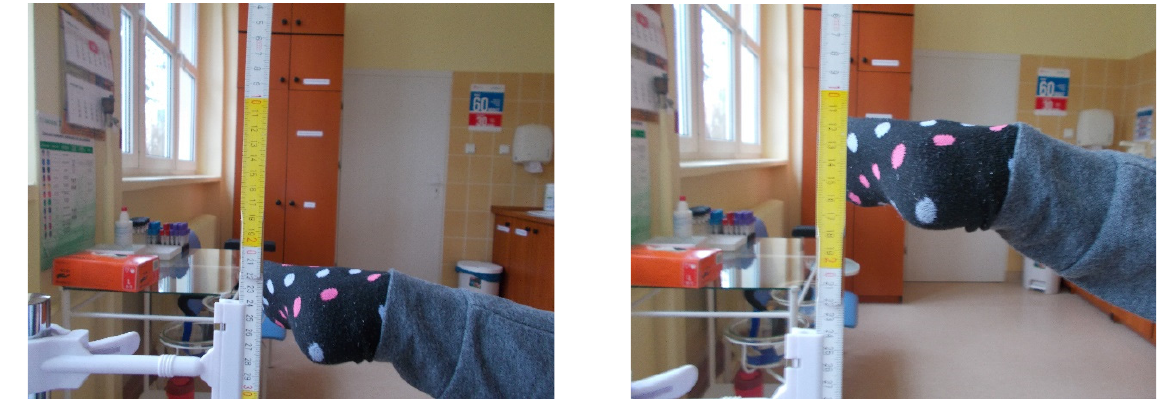
Figure 2. Clinical examination of the hip abductor muscle function Hip Lag Sign test.